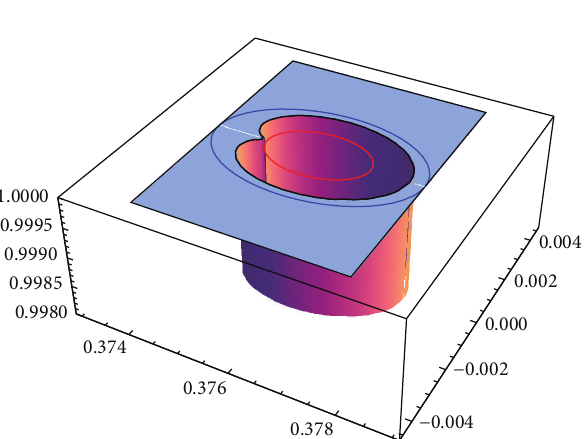
Figure 14: |𝑆𝑡 14 (𝛼)| = 1 and the corona (𝐶 1 ,𝐶 2 )